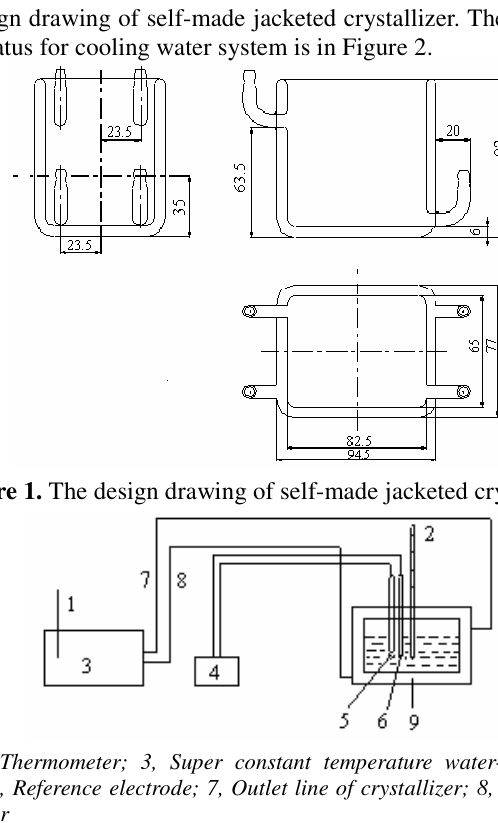
Figure 2. The sketch of experimental